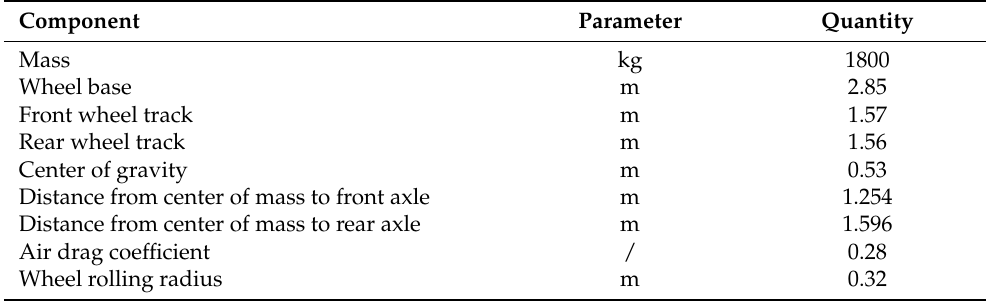
Table 1. The parameters of the vehicle.